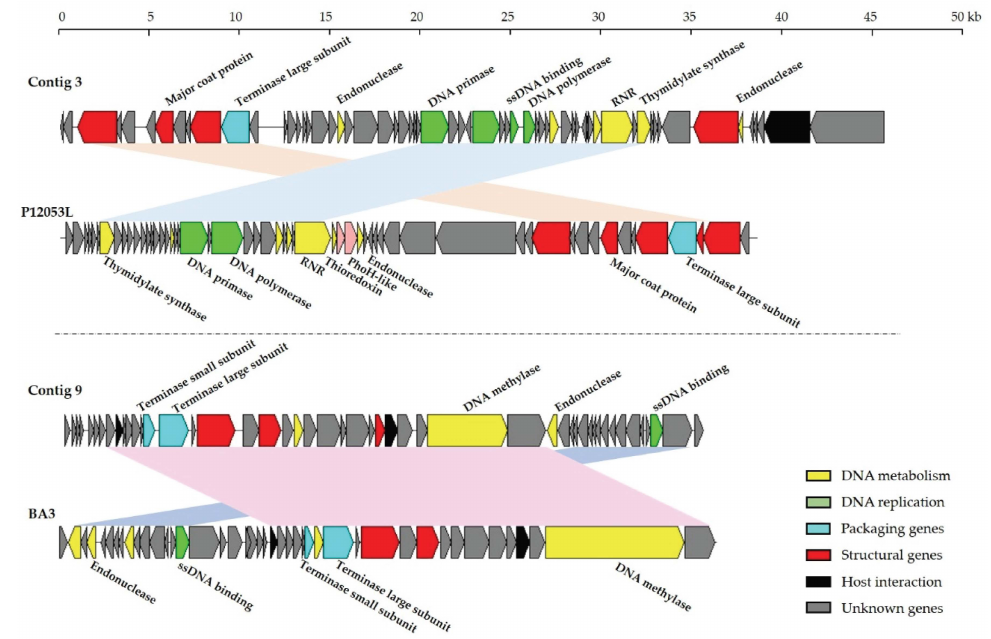
Figure 5. Comparisons of contigs 3 and 9 with Celeribacter phage P12053L and Thalosomonas phage BA3 , respectively. ORFs are depicted by leftward or rightward oriented arrows according to the direction of transcription. Colored arrows denote putative functions assigned by Blastp similarity. Homologous ORFs are connected by